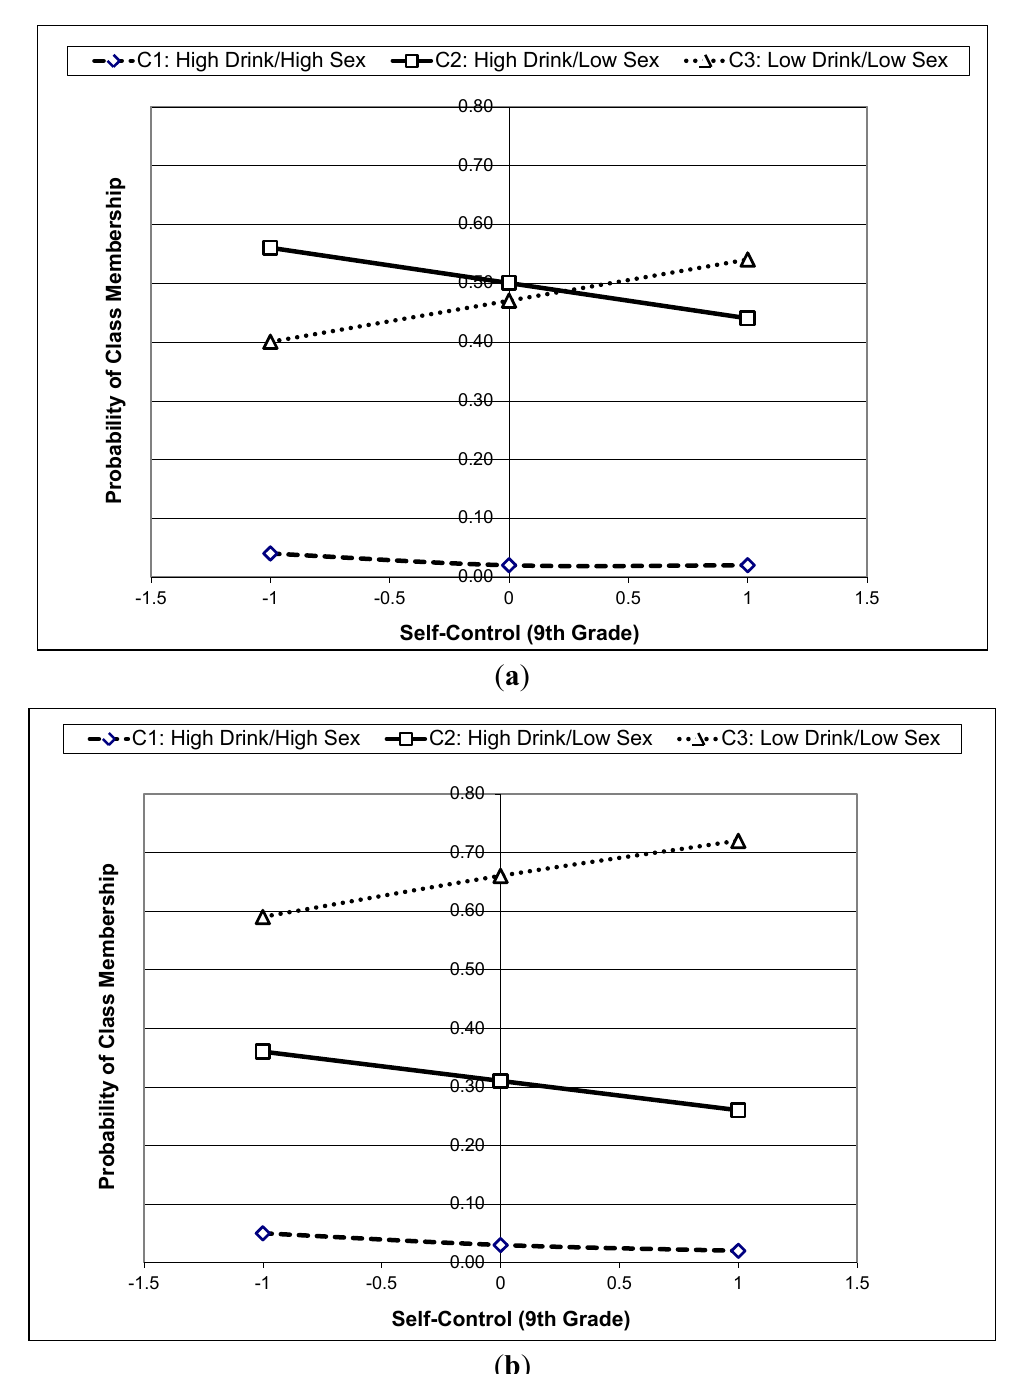
class assignment for Class 2 (high-low) are somewhat higher in the black compared to non-black women, although the line is negatively sloped in both groups. Figure 2. ( a ) Probability of class membership in young adulthood as a function of 9th grade self-control among black women; ( b ) Probability of class membership in young adulthood as a function of 9 th grade self-control among other women (reference